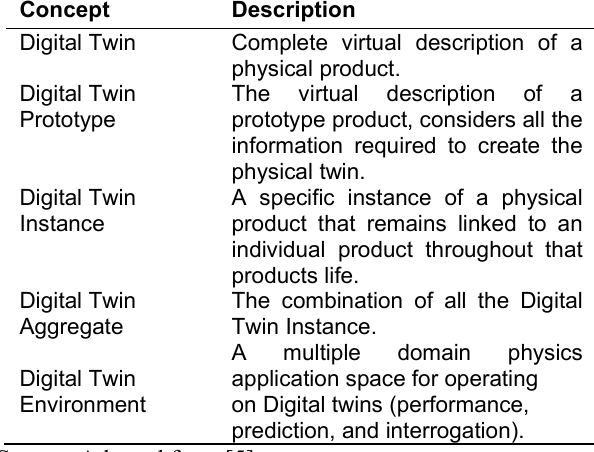
Table 1. Concepts associated with the Digital Twin